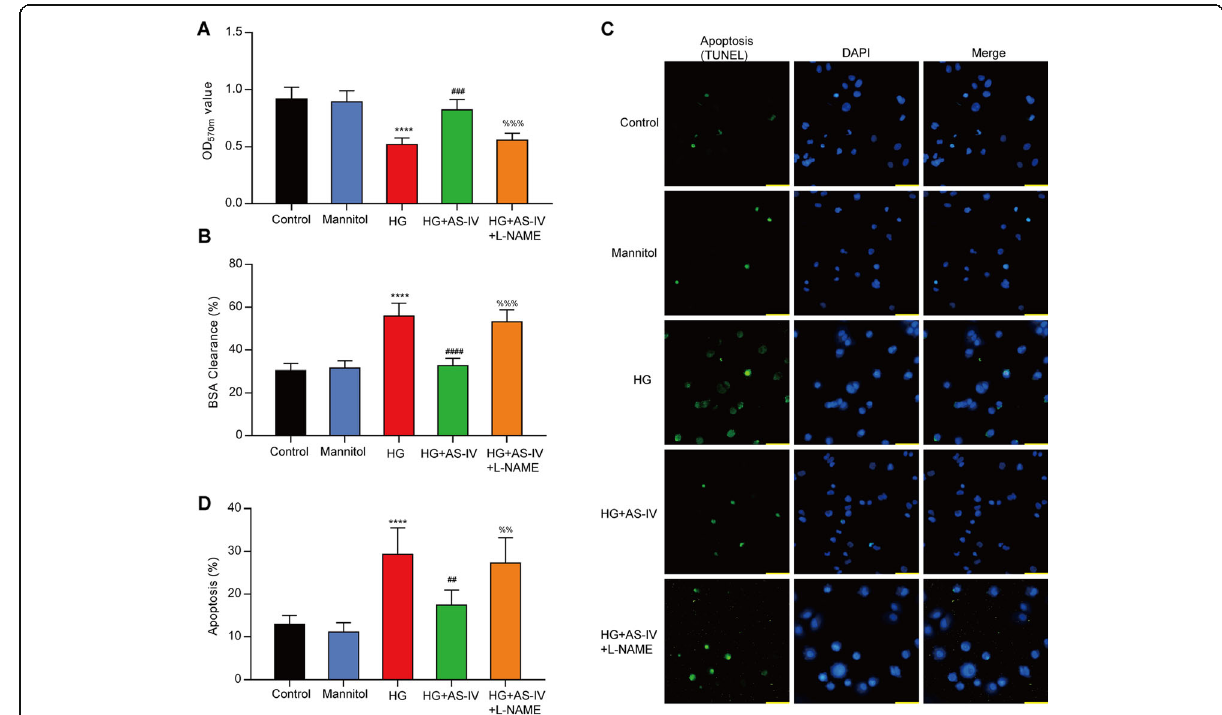
Fig. 4 High glucose increased cell permeability and apoptosis in HRGECs, whereas these effects were inhibited by AS-IV. a Cell viabilities in HRGECs were matured by MTT assay. All results were expressed as mean ± SD ( n = 5). b The permeability of HRGECs was evaluated by BSA clearance as described in methods. c HRGECs were stained using TUNEL or DAPI, bar = 50 μ m. d Effect of HG on apoptosis in HRGECs was